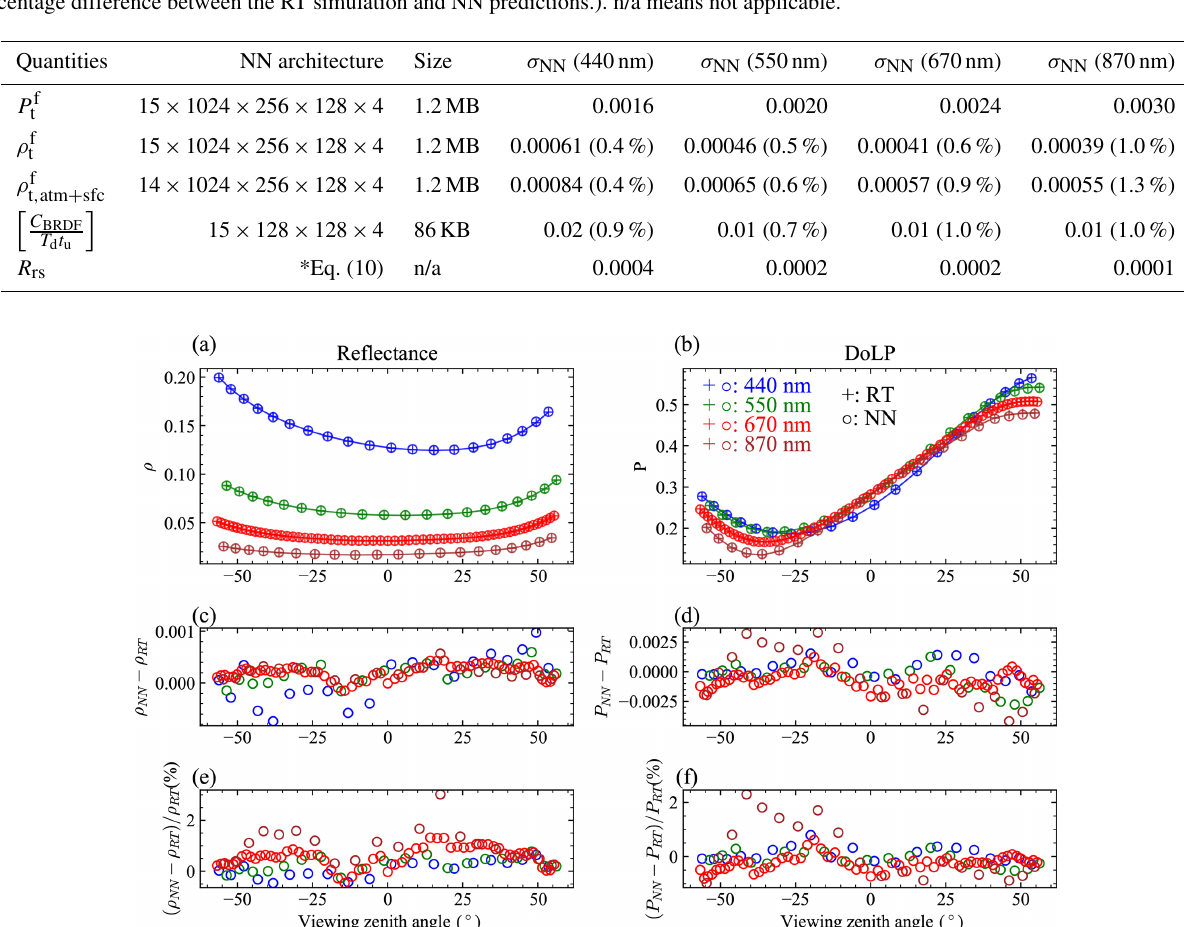
and [ C BRDF /T d t u ] t , atm + sfc